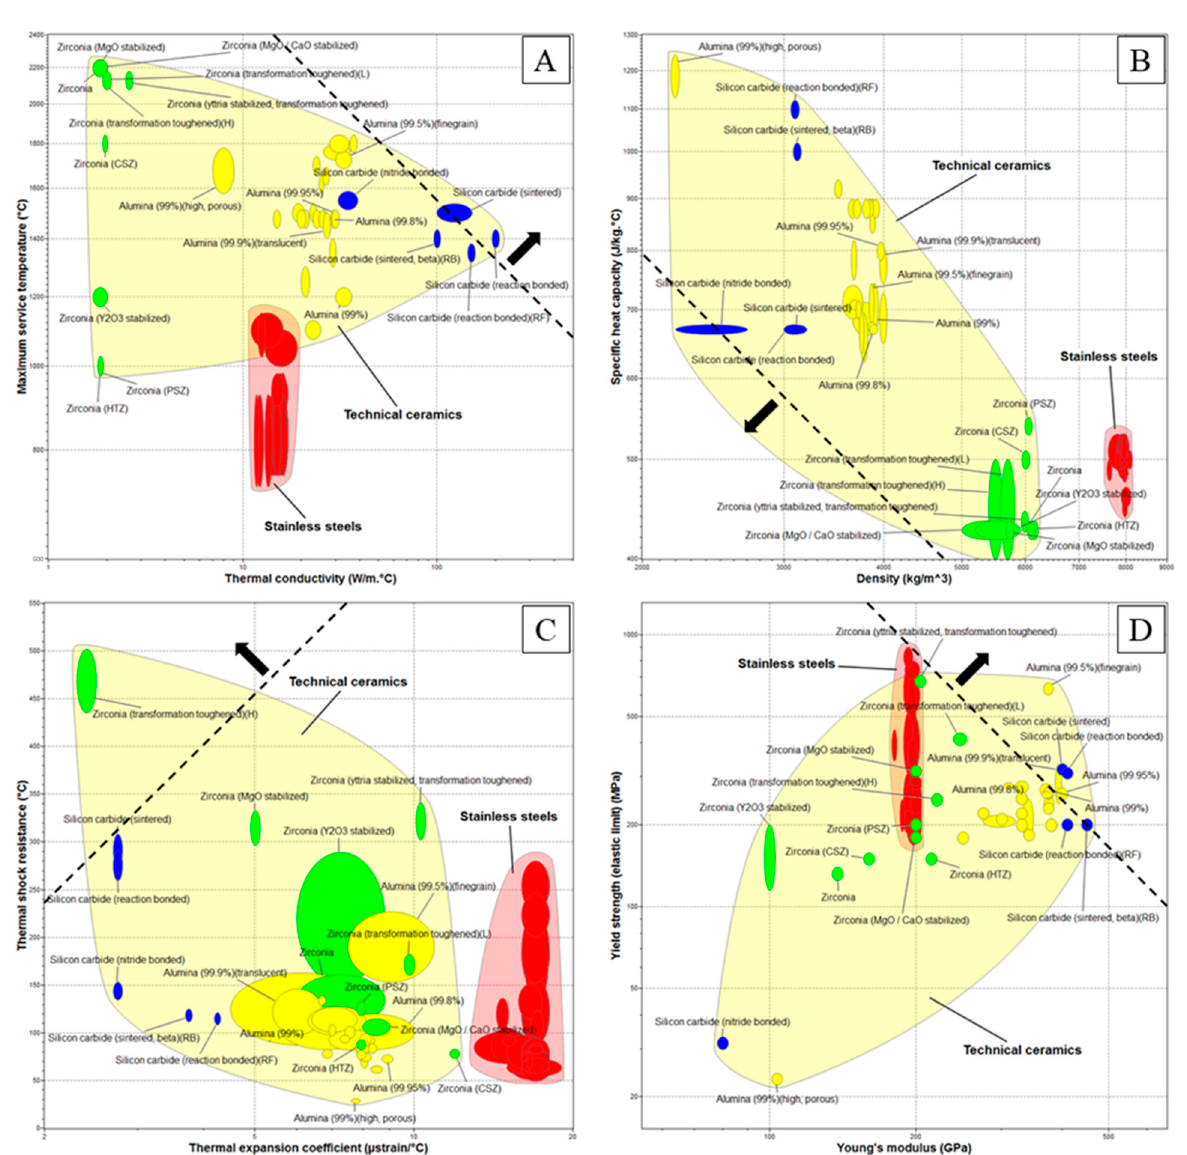
Figure 4. Ashby materials property chart for technical ceramics and stainless steels at 25 °C: ( A ) thermal conductivity against maximum service temperature; ( B ) density against specific heat capacity; ( C ) thermal expansion coefficient against thermal shock resistance; ( D ) Young’s modulus against yield strength. Areas’ legend: Silicon Carbide—blue; Zirconia—green; Alumina—yellow; Stainless steel—red. Materials properties were obtained from Ansys GRANTA EduPack software, ANSYS, Inc., Cambridge, UK, 2021 (www.ansys.com/materials, accessed on 30 April 2021).